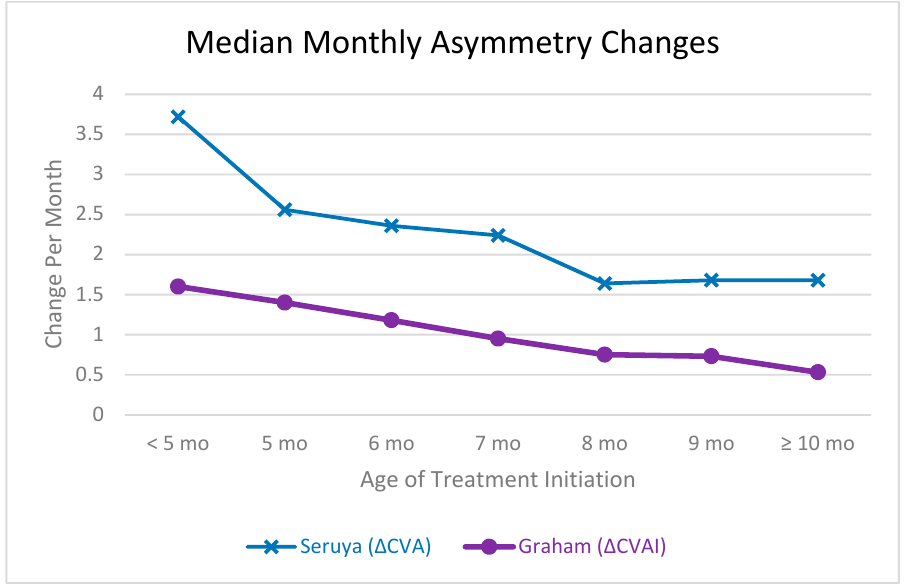
Figure 2. Study comparison of median monthly asymmetry changes in CVA or CVAI based on infant starting age (Seruya n = 346, Graham n = 498).